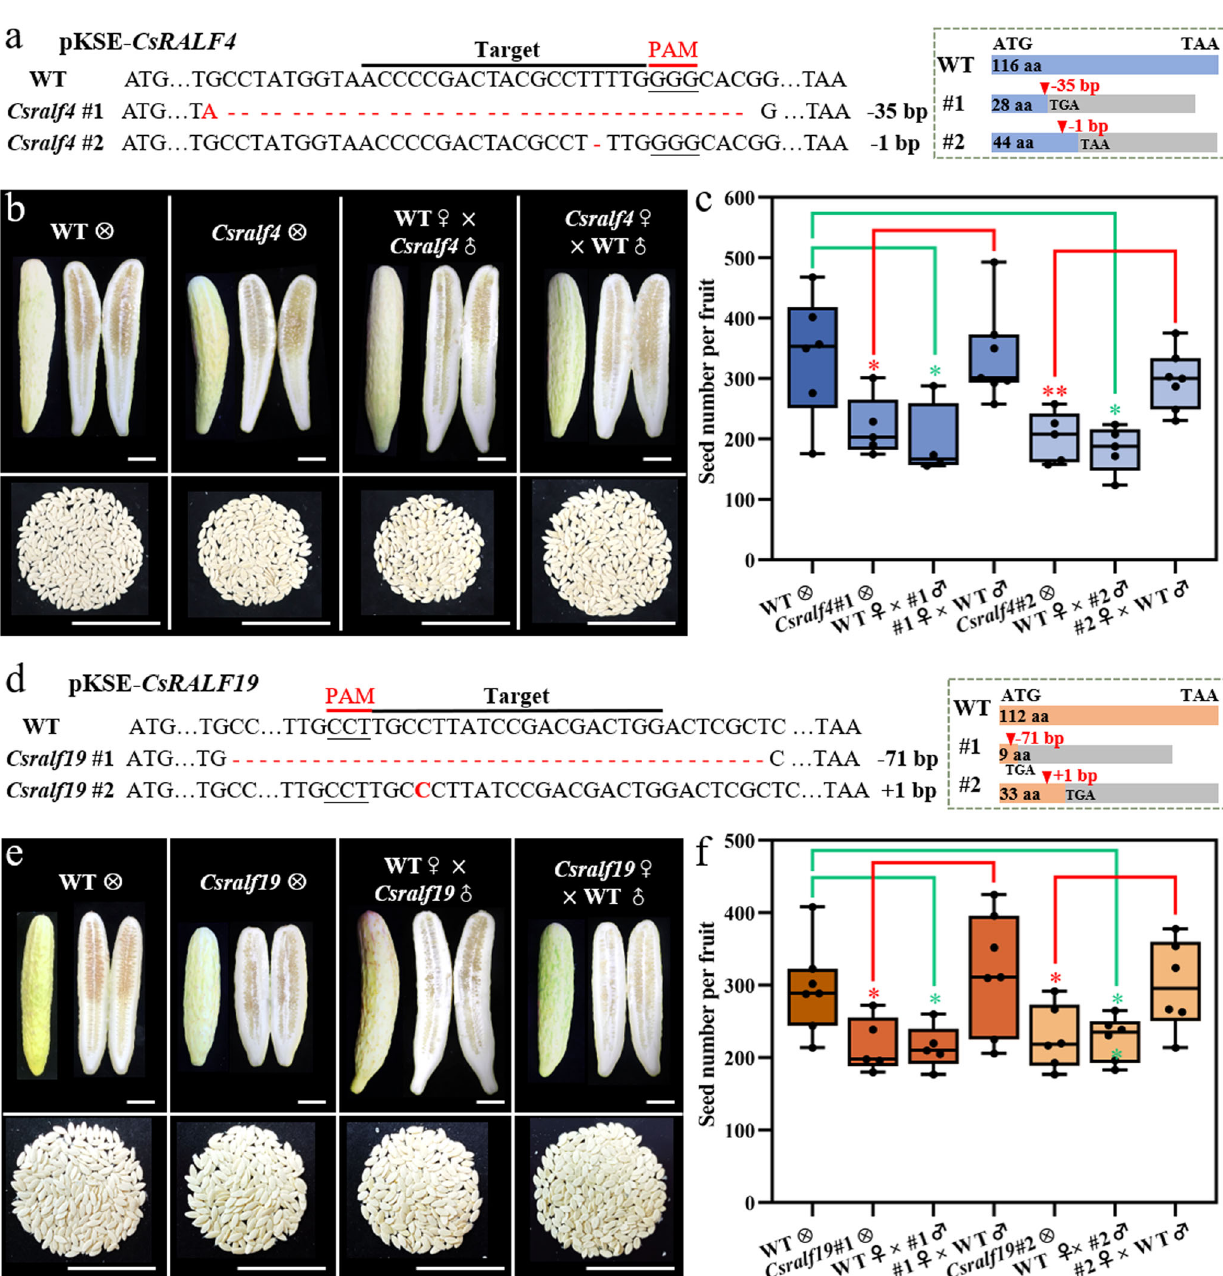
from frameshift mutations. aa amino acid. b , e Mature fruits, corresponding longisection, and harvested seeds from reciprocal crosses between Csralf4 mutants ( b )/ Csralf19 mutants ( e ) and WT. Scale bars=5cm. c , f Quantitative ana- lysis of seed number from ( b , e ). Upmost/lowest lines indicate the maximum/ minimum values, box limits indicate the upper and lower quartiles, and lines in boxesindicatethemedianvaluesofthesedata.Fromlefttoright, n =6,5,4,7,5,5, 7maturefruitsin( c )and7,5,5,7,6,6,6maturefruitsin( f ),respectively.* p <0.05, ** p <0.01 (two-sided Student ’ s t